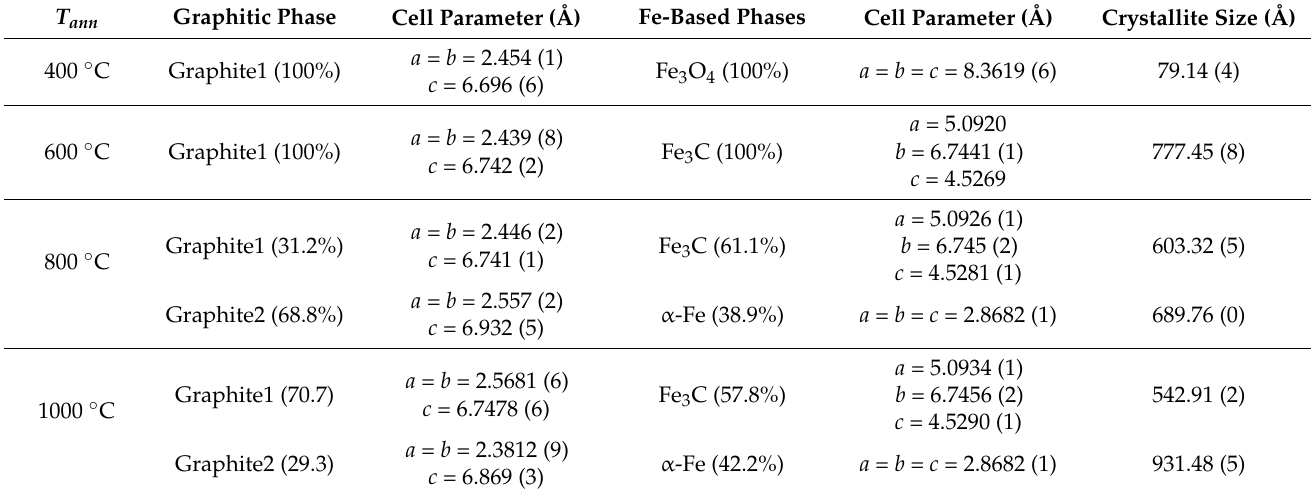
Table 1. Parameters obtained from Rietveld refinement of the XRD of the graphitic and Fe-based